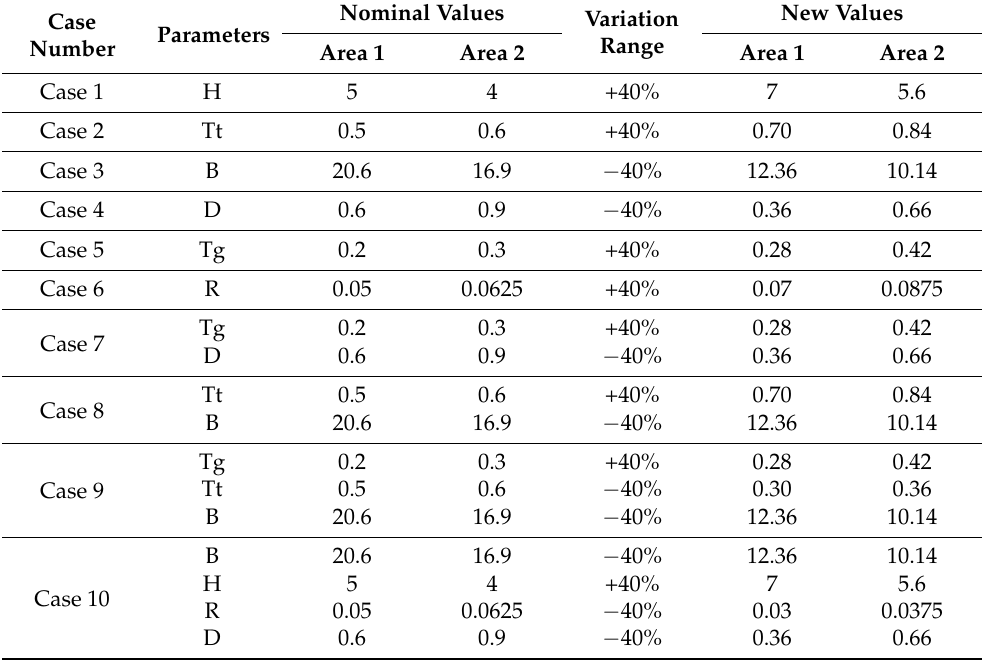
Table 6. Different investigated scenarios of system parametric